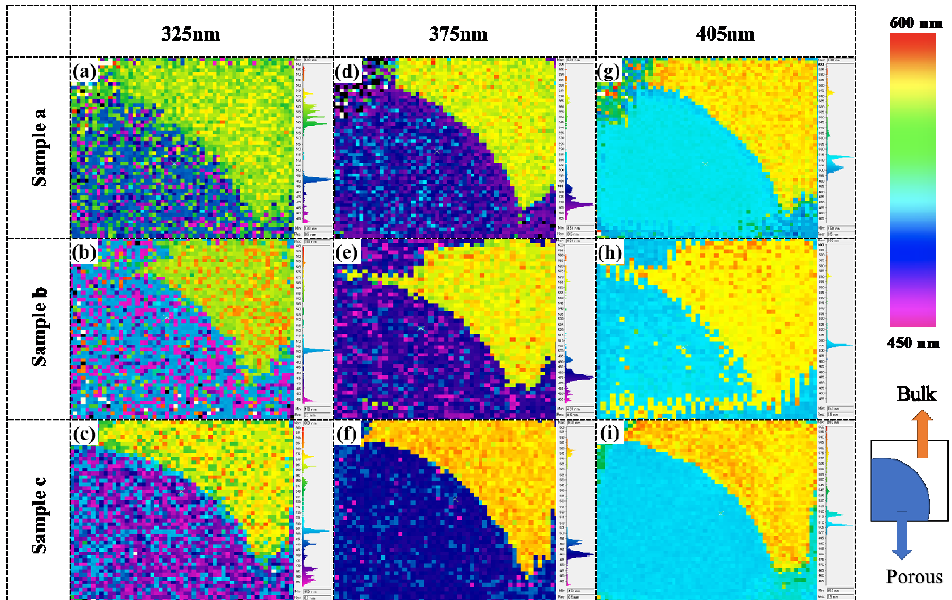
Figure 6. PL mapping of the porous fluorescent SiC samples a, b, and c, after passivation and under excitation, by ( a – c ) the 325 nm laser, ( d – f ) the 375 nm laser, and ( g – i ) the 405 nm laser, respectively. The color bar and configuration of the porous samples are illustrated on the right.